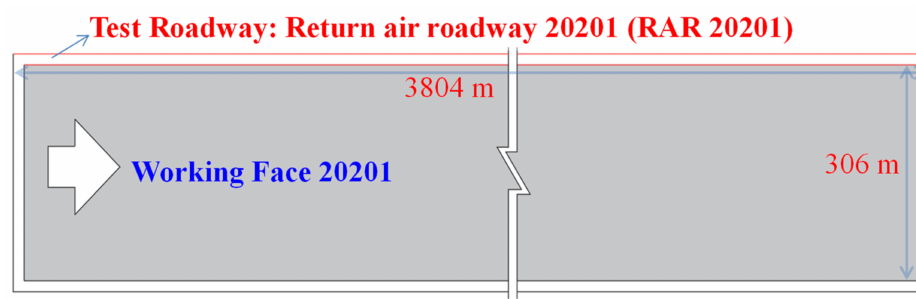
Figure 1. Layout of working face and location of test